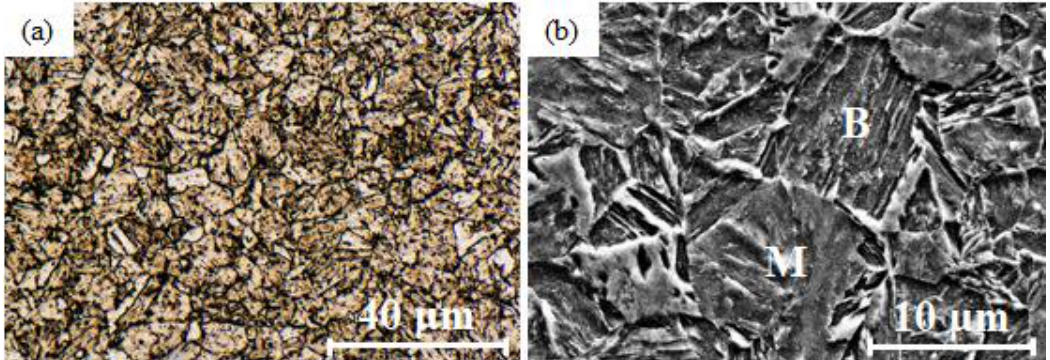
Figure 4. ( a ) LOM and ( b ) SEM images from the 25 °C die-quenched microstructure of Ductibor ® 1000-AS (M: martensite).